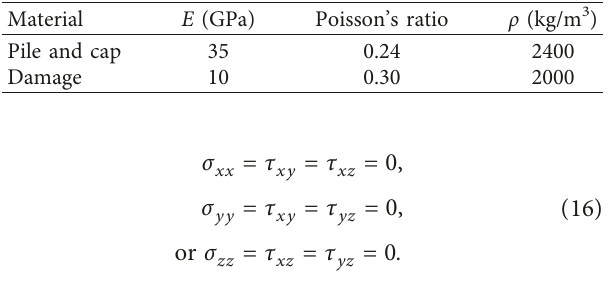
Table 4: Parameters of the pile-soil